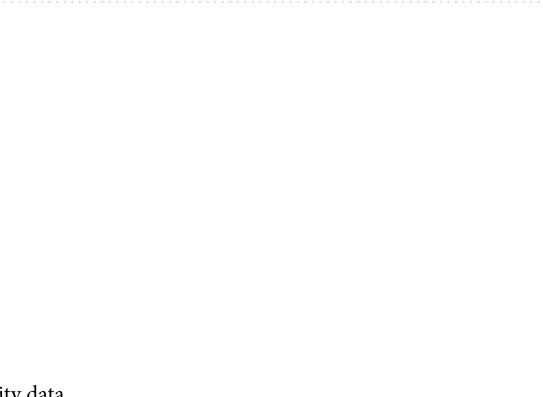
Table 3. UK second-wave validation for mortality data.